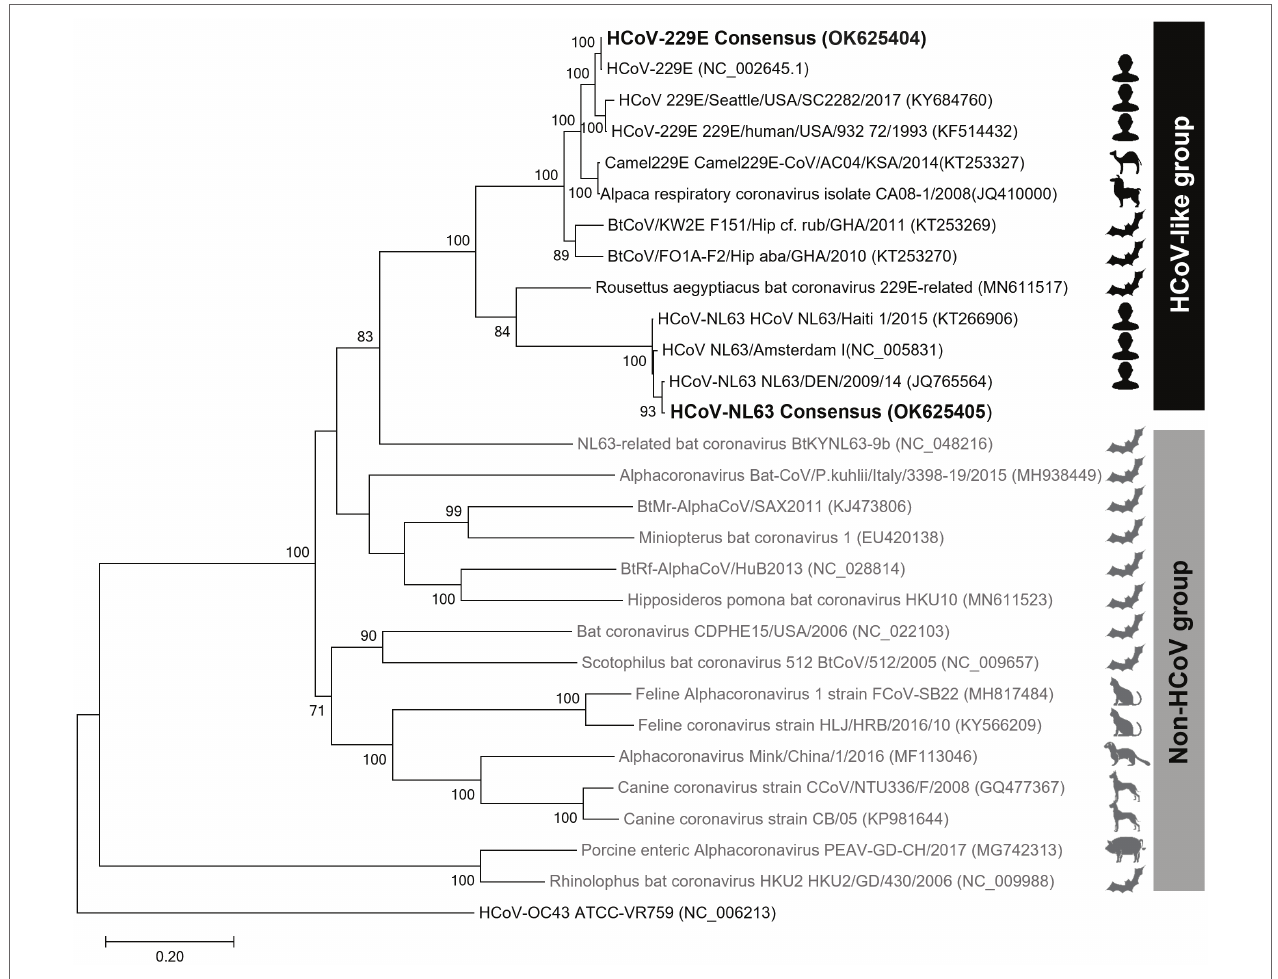
FIGURE 3 | Spike protein amino acid sequence tree of alphacoronaviruses. The maximum-likelihood tree was inferred using the sequences at the 20,572– 24,090 nt positions of the spike protein subunit1 (S1). The ingroups are the 28 representative sequences of 14 subgenera of alphacoronaviruses, and HCoV-OC43, a betacoronavirus, was used as an